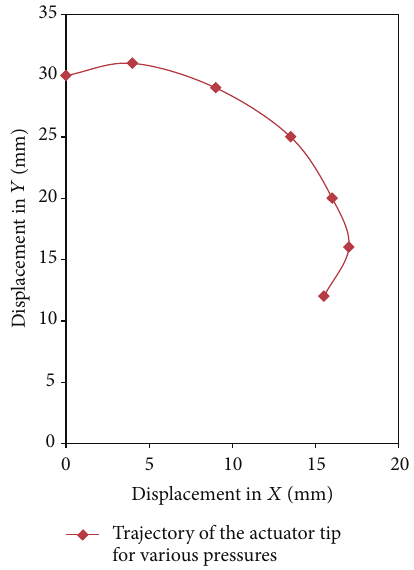
Figure 18: Trajectory of the tip motion of the actuator.